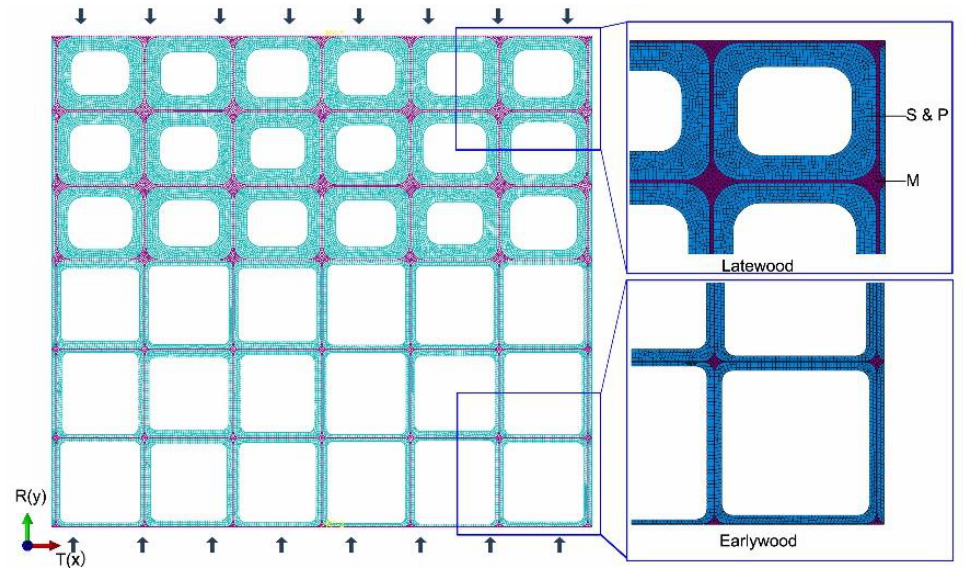
Figure 2. Schematic of the finite element model (S means the secondary wall; P means the primary wall; M means the middle lamella; R(y) means the y axis is the radial direction; T(x) means the x axis is the tangential direction).